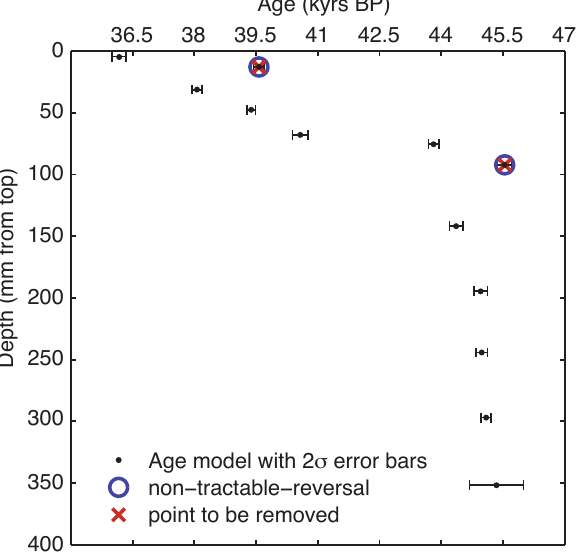
Fig. 7. Reversals: two non-tractable reversals have been identified in TSAL-1 by COPRA. The two outliers cause age reversals and must be evaluated and (can be) eliminated within the algorithm.